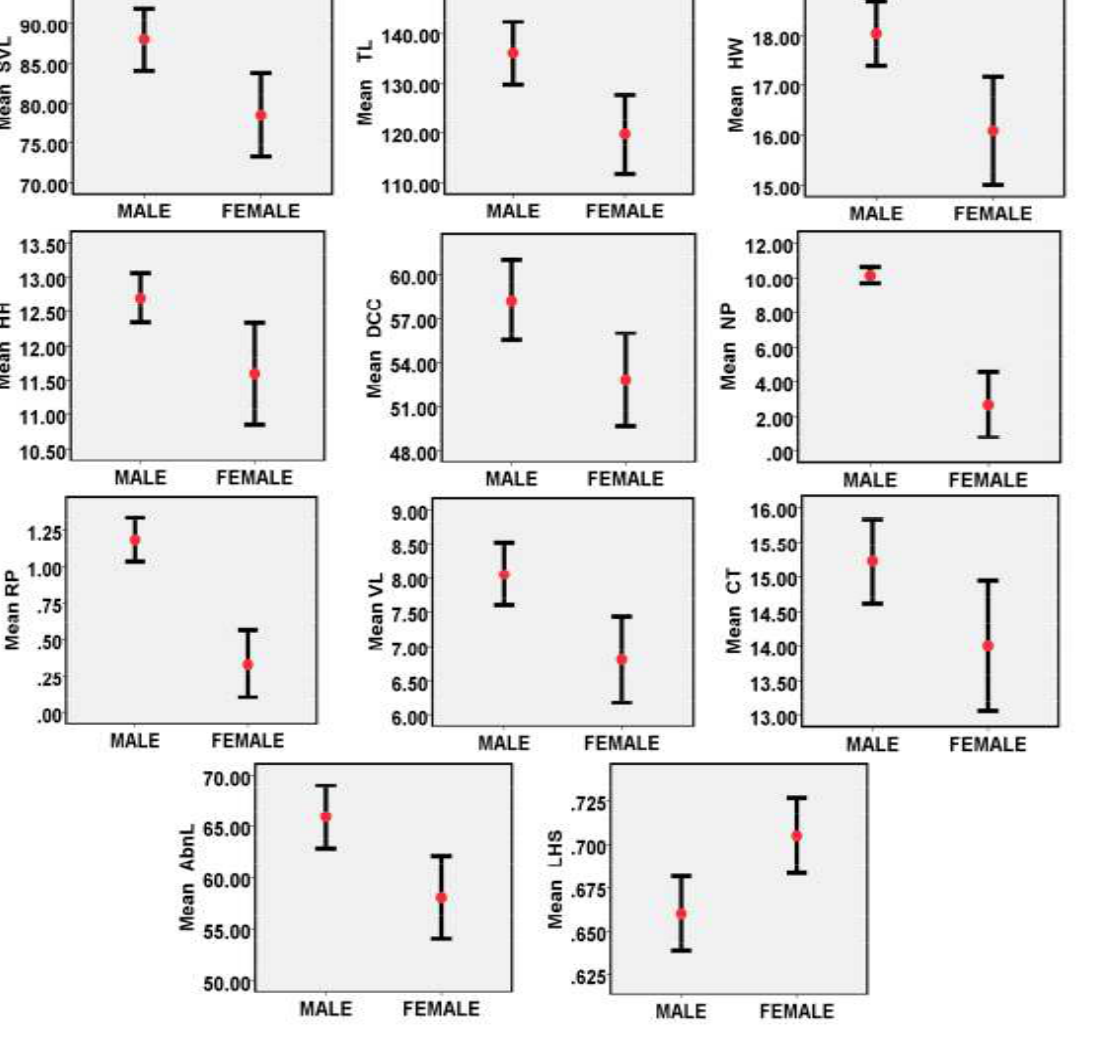
F IGURE 2 . The mean and standard error for significantly different characters between males and females of Trapelus r. ruderatus revealed from the analysis of variance